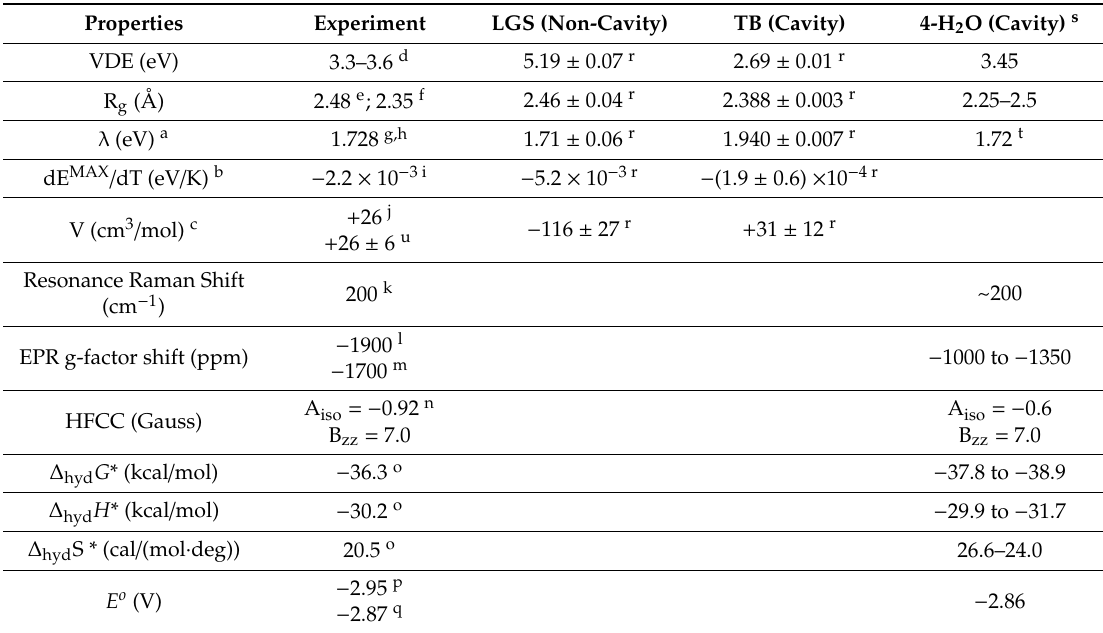
Table 1. A Comparison of the Cavity Versus Non-Cavity Models of the Solvated Electron in